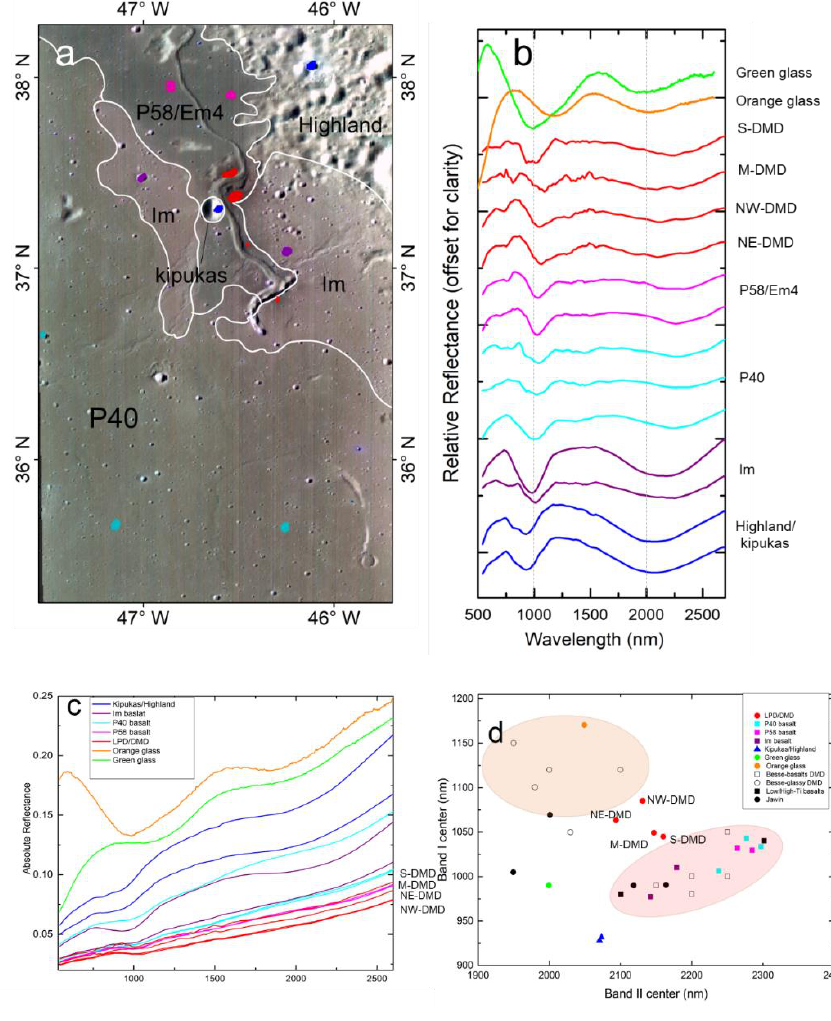
Figure 4. Spectra of DMDs and surrounding materials. ( a ) The location of the extracted spectra. ( c ) and ( b ) are the original spectra and the continuum-removed spectra, respectively. The laboratory spectra of orange (Apollo 17 sample 74220) and green volcanic glasses (Apollo 15 sample 15401) are also displayed [ 18 , 47 ] . ( d ) Band center positions at 1 μm and 2 μm extracted from the continuum- removed Figure 4b. The band positions of low- and high-Ti basalts were extracted from [ 42 ] and are marked using black squares. The band positions of the DMDs marked by black dots were extracted from [ 16,43 ] . The DMDs in this study is located halfway between two populations of orange glasses (orange area) and mare basalts (pink area).